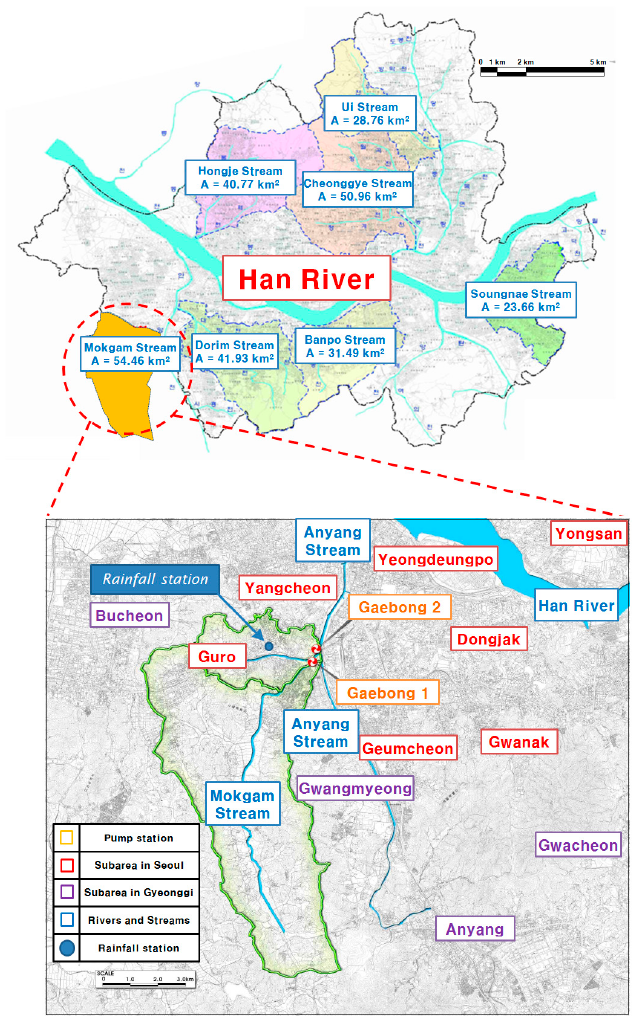
Figure 7. Location of the target watershed.